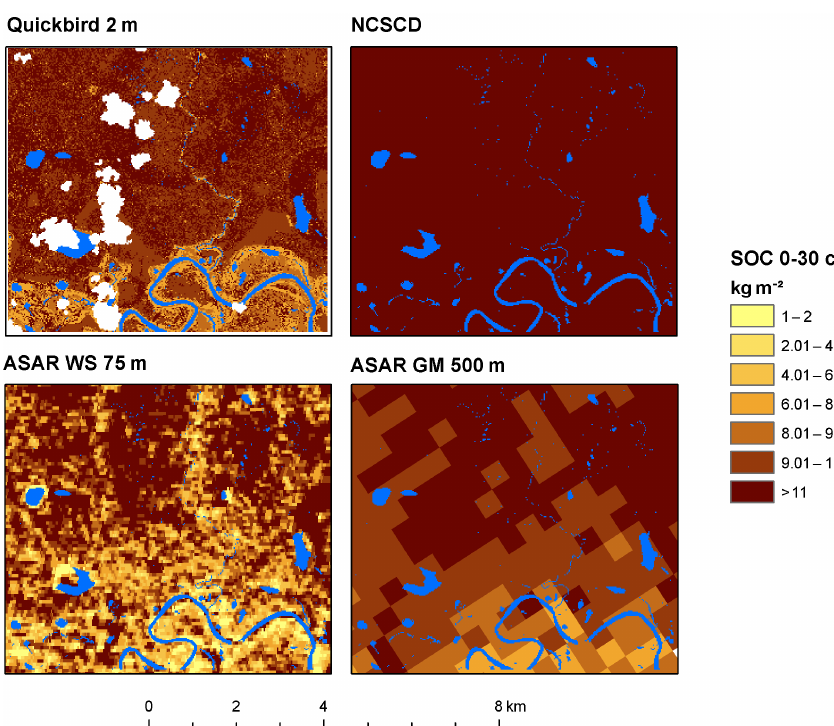
Figure 12. SOC 0–30cm from QuickBird (Siewert et al., 2015), NCSCD (Hugelius et al. (2014)), ENVISAT ASAR WS and GM (resampled to a grid with polar stereographic projection) for Kytalyk. Water bodies and clouds from QuickBird classification are shown in blue and white respectively. NCSCD contains a constant value of 17kgm − 2 across the